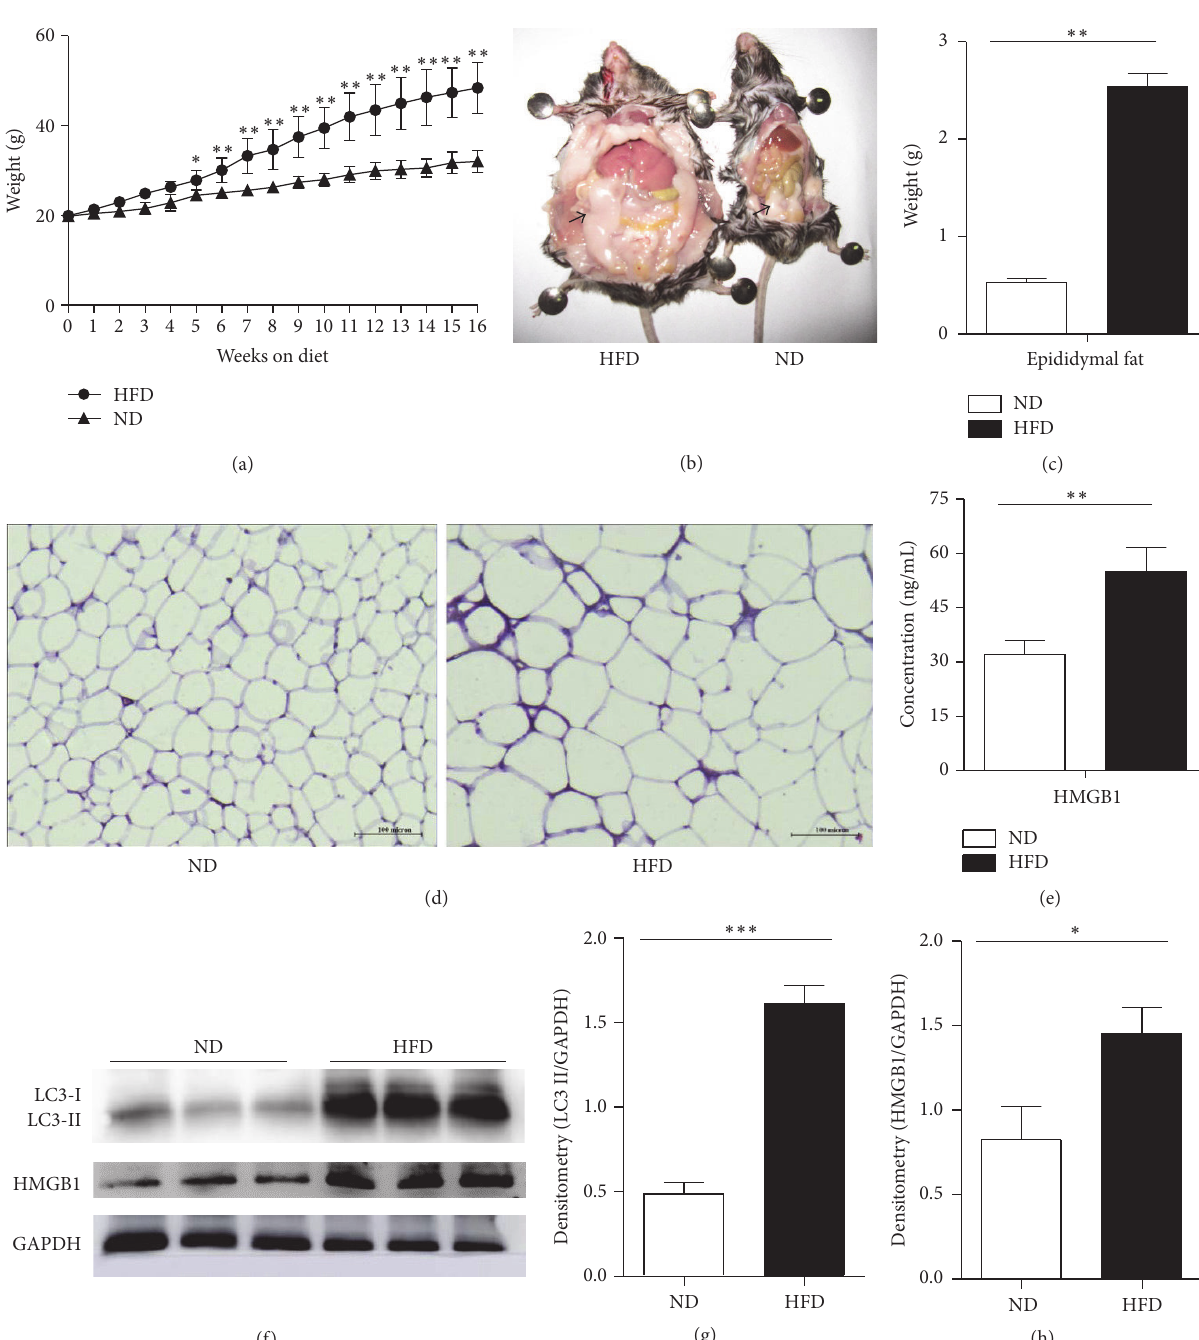
Figure 1: Effects of HFD on HMGB1 and LC3. After male mice were fed with HFD and ND for 16 weeks, serum was separated, and the epididymal adipose tissue was extracted. (a) The change of the body weight. (b) The epididymal adipose tissue, HFD (left) and ND (right). The black arrow pointed to epididymal adipose tissue. (c) The weight of epididymal adipose tissue. (d) HE staining of epididymal adipose tissue. (e) Levels of HMGB1 in peripheral blood were analyzed by ELISA. (f) The expression of autophagy protein LC3II and HMGB1 was analyzed by Western blot. (g-h) The protein levels were quantified through normalization with GAPDH, ∗ 𝑃 < 0.05 , ∗∗ 𝑃 < 0.01 , and ∗∗∗ 𝑃 < 0.001 for comparisons between ND and HFD mouse epididymal adipose